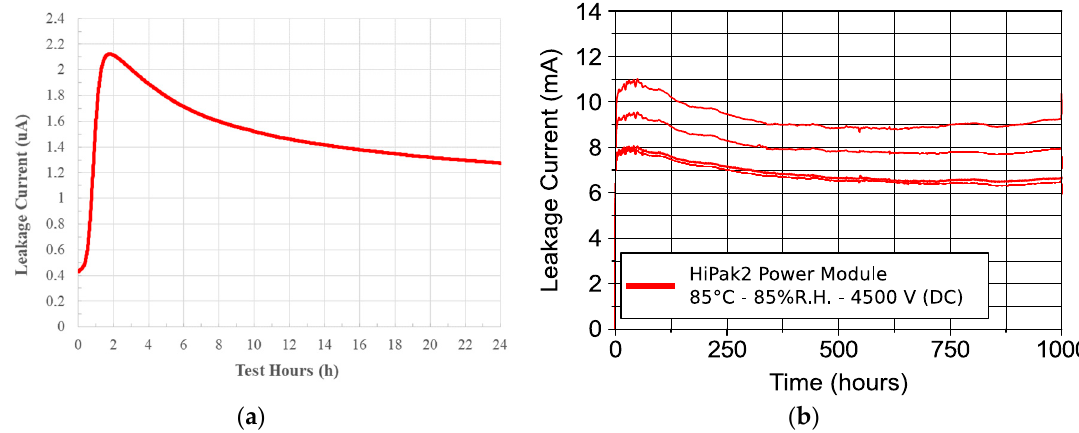
Figure 2. Typical leakage monitoring curves for a single 650 V power diode in the first 24 h of HV-THB testing at 85 °C and 85% R.H.—reverse biased at 80% V nom ( a ). Evolution of HV-THB testing for a set of 4 power modules with 24 IGBTs and 12 diodes each, tested at 85 °C and 85% R.H. with a reverse bias at 4500 V ( b ). ( a ) Reproduced with permission from [8] and ( b ) reproduced with permission and adapted from [21].